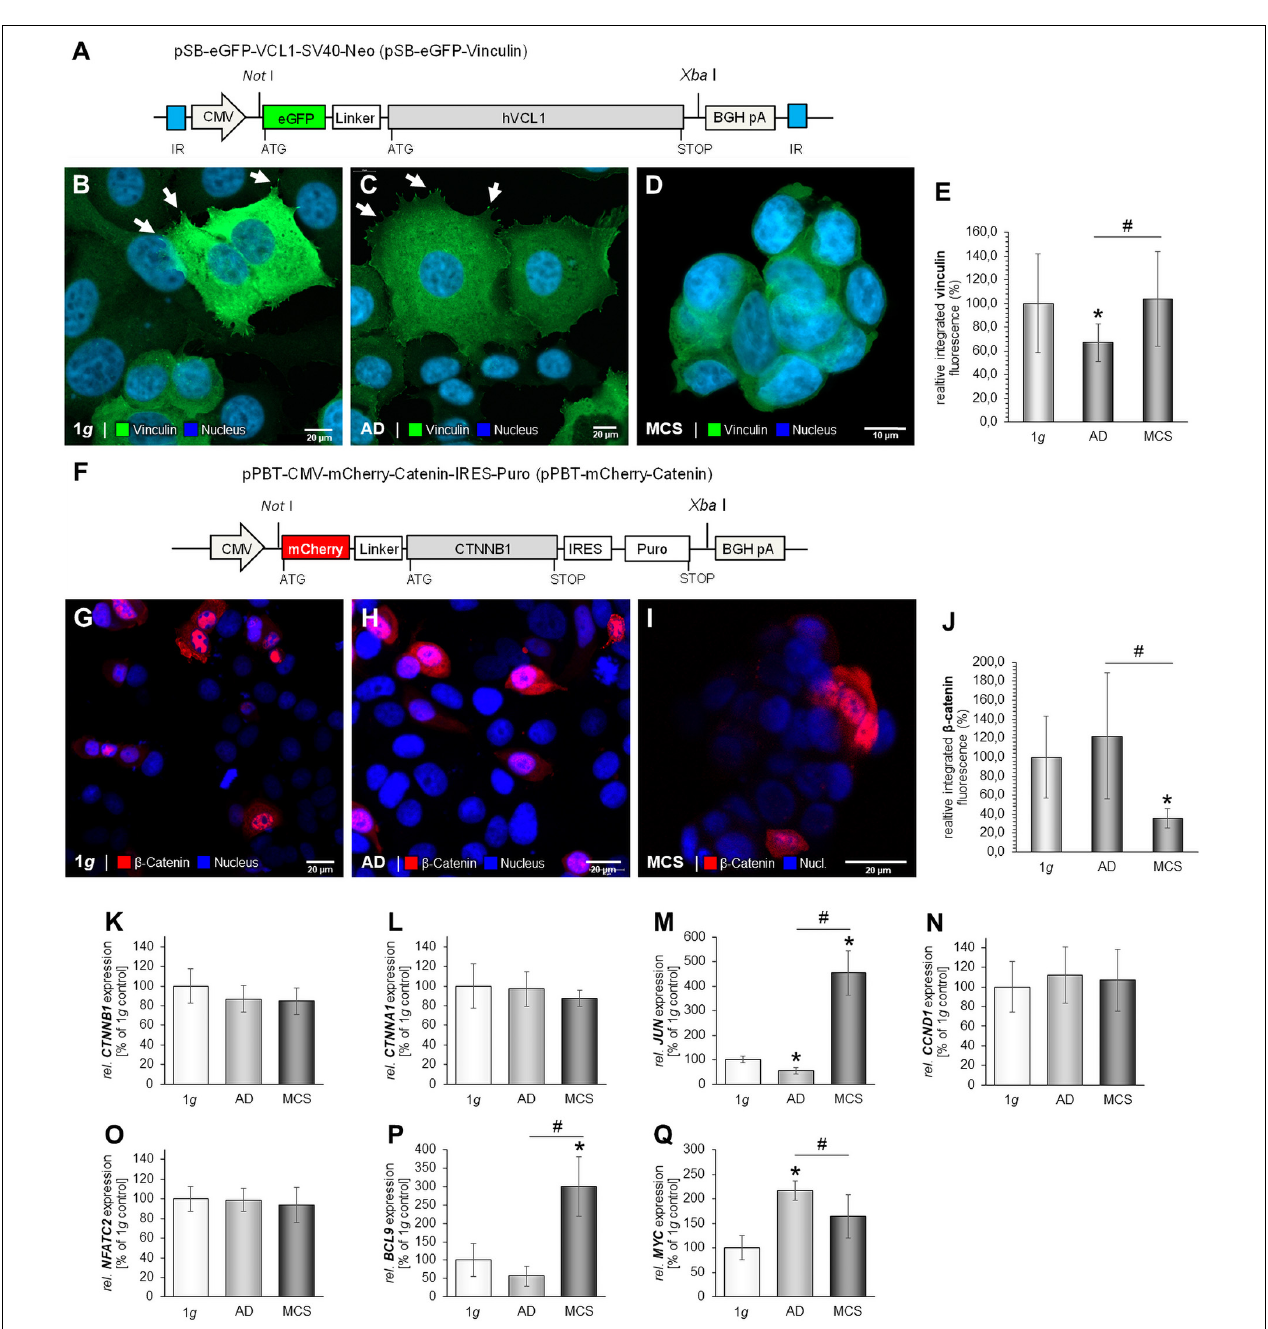
FIGURE 8 | Stable expression of eGFP-vinculin in MCF-7 cells. Following co-transfection of pSB-eGFP-vinculin and pCMV-SB100X cells were cultured in medium containing G418 to allow growth of stably transfected cells only. (A) Graphic illustration of the pSB-eGFP-vinculin plasmid containing the coding sequence of the eGFP-vinculin fusion protein encoded from a CMV promoter. Restrictions used for cloning are indicated. BGH pA, bovine growth hormone polyadenylation site; CMV, cytomegalovirus promoter; IR, internal repeats. (B) Image of eGFP-vinculin in MCF-7 cells subjected to 1 g . The white arrows show lamellipodia and vinculin focal adhesion dots. (C) Image of eGFP-vinculin in MCF-7 cells after RPM exposure. The white arrows indicate vinculin dots (D) Image of eGFP-vinculin in MCF-7 MCS following RPM-exposure. Scale bars 10 µ m. Expression of mCherry-catenin in MCF-7 cells. MCF-7 cells were transfected with pPBT-mCherry-catenin and images were captured 48 h post transfection. (E) Analysis of the fluorescence intensity of eGFP-vinculin. (F) Graphic illustration of the pSB-eGFP-vinculin plasmid containing the coding sequence of the eGFP-vinculin fusion protein encoded from a CMV promoter. Restrictions used for cloning are indicated. BGH pA, bovine growth hormone polyadenylation site; CMV, cytomegalovirus promoter. (G) Image of MCF-7 cells expressing mCherry-catenin at 1 g . (H) Image of RPM-exposed adherent MCF-7 cells expressing mCherry-catenin following incubation at µ g . (I) Image of MCF-7 MCS expressing mCherry-catenin following incubation at µ g . Scale bars 20 µ m. (J) Analysis of the fluorescence intensity of mCherry-catenin. Gene expressions of CTNNB1 (K) ; CTNNA1 (L) ; JUN (M) ; CCND1 (N) ; NFATC2 (O) ; BCL9 mRNA (P) and MYC (Q) , MCF-7 cells exposed to the RPM. * p < 0.05 1 g vs. AD and/or MCS and # p < 0.05 AD vs. MCS.